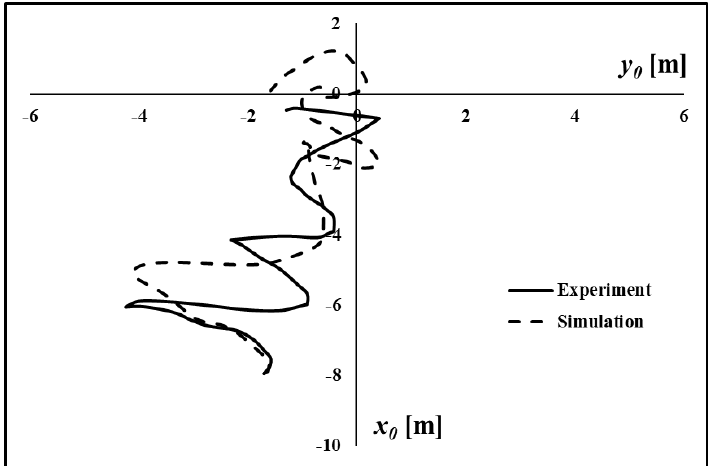
Figure 23. Comparison of experiment and simulation at P8.